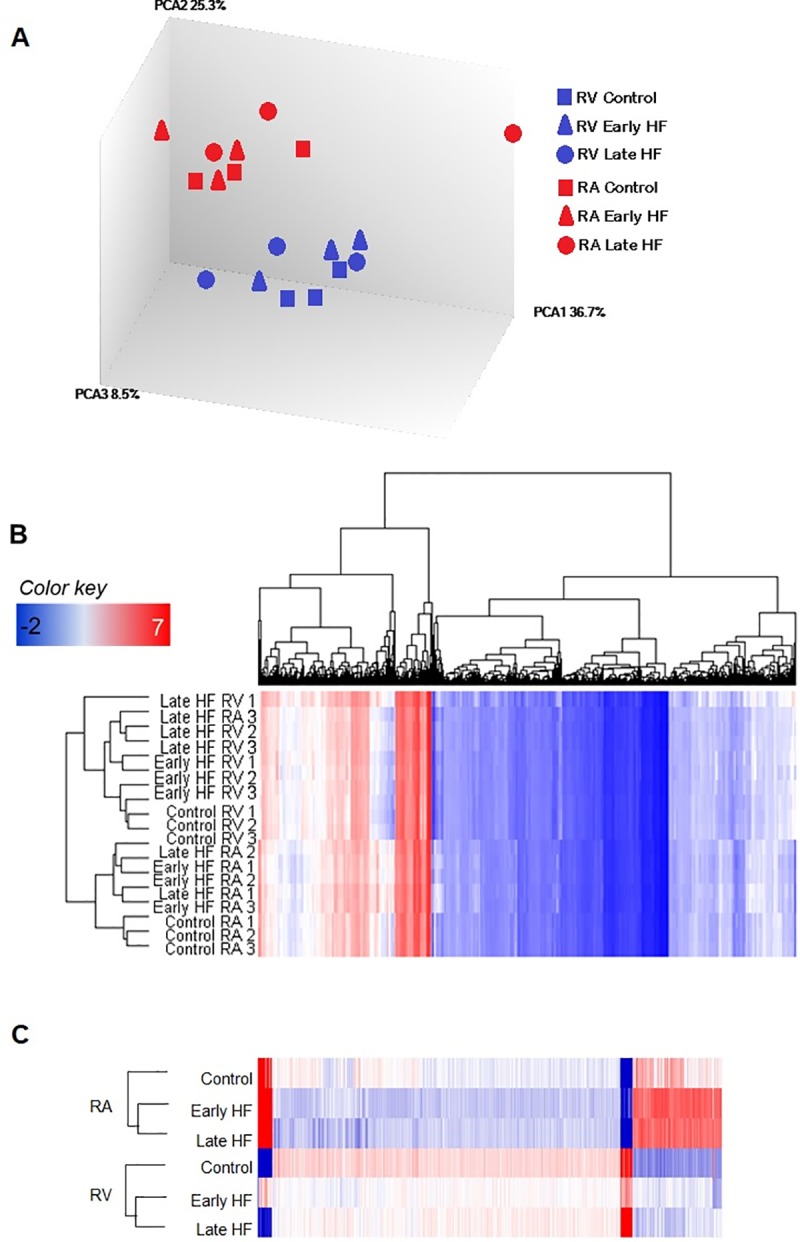
Principal component and clustering show a clear separation between controls and heart failure.(A) Three-dimensional principal component analysis (PCA) plot of multi-array average–normalized data for early and late stages of HF in RA (red) and RV (blue). (B) Unsupervised hierarchical clustering of the global gene expression data. (C) Unsupervised hierarchical clustering of the 534 identified differentially expressed genes (DEGs) for the averaged data. (ANOVA, p<0.01, n = 3). Data are log transformed and normalized. Upregulated genes are displayed in red and downregulated genes in blue. Dendrogram provides a measure of the relatedness of gene expression in each sample (at left) and for each gene (at top).